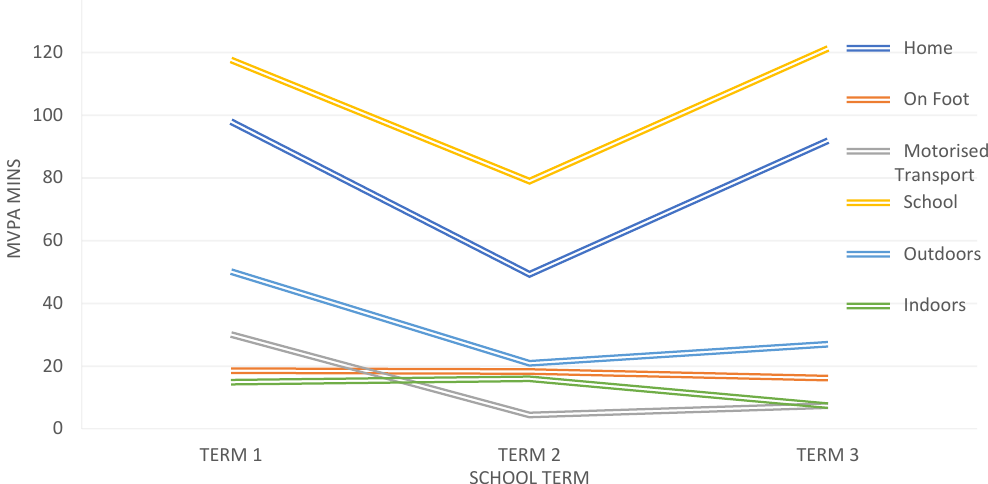
Figure 2. Mean daily moderate–vigorous physical activity (MVPA) time (mins) according location each school term.